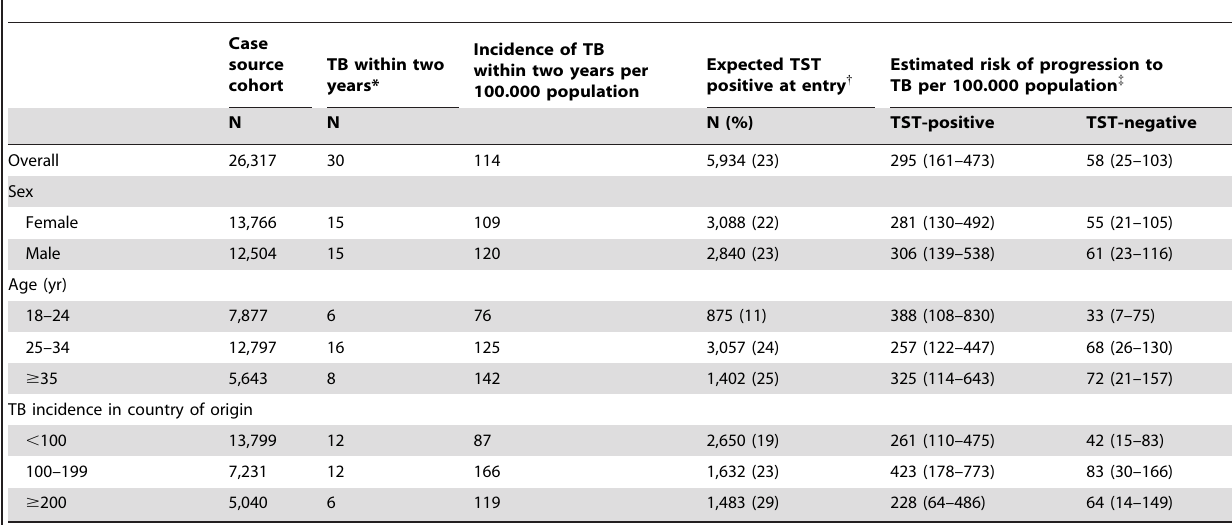
Table 4. Risk of progression to TB within two years after entry screening for TST $ 15